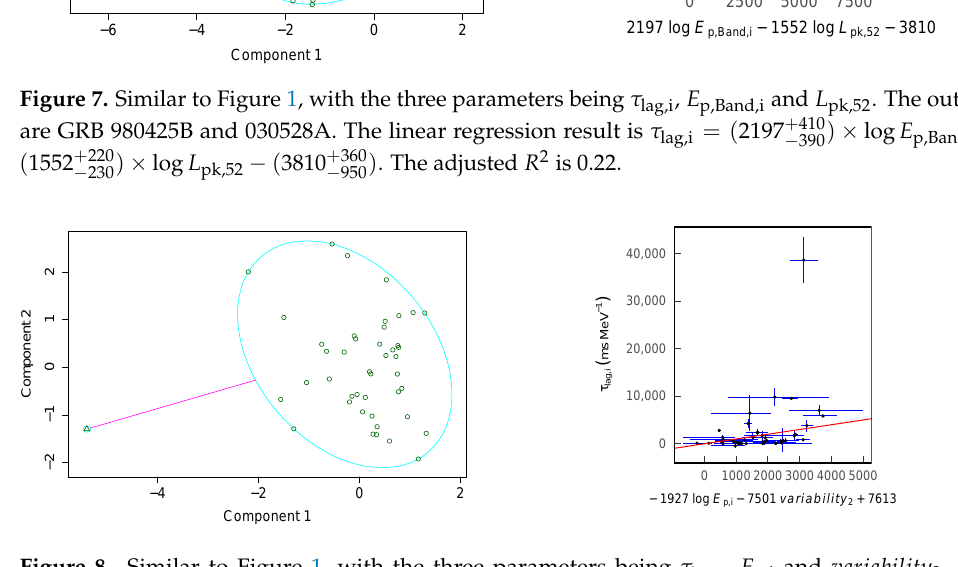
) × log E − ( 7501 + 3600 ) × p,i − 3200 500